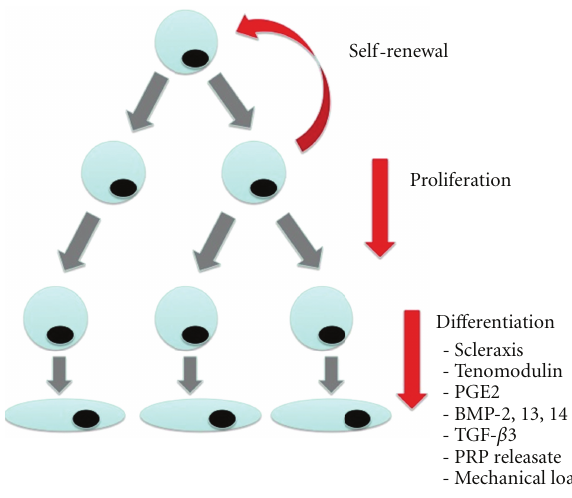
Figure 1: Pathway of mesenchymal stem cell di ff erentiation into